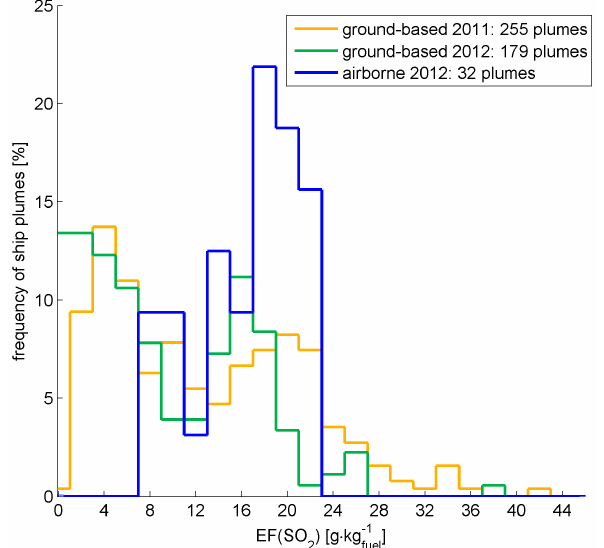
Figure 4. The frequency distribution of the measured emission fac- tors of SO 2 . Two main modes can be identified for the ground- based measurements; one for small SO 2 emission factors below and around 4g SO kg − 1 , and the other one for 20g SO fuel 2 and 16g SO kg − 1 in 2012. fuel 2